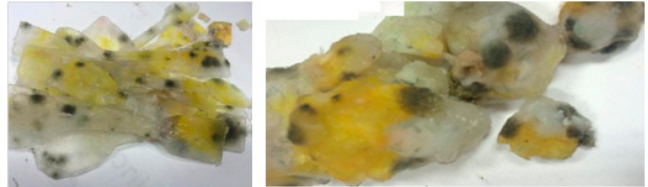
Figure 4. Samples of starch films undergoing biodegradation.